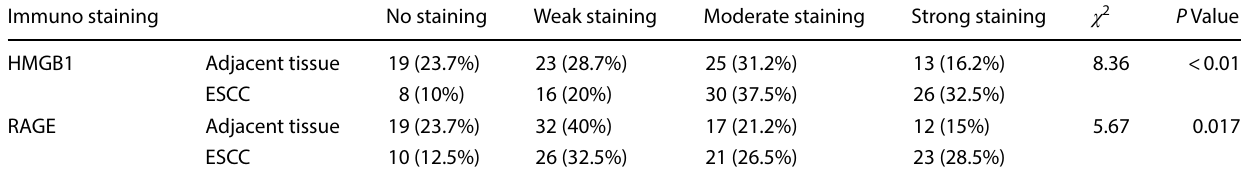
Table 2 Immunohistochemical analysis of HMGB1 and RAGE expression patterns in two groups including ESCC group and adjacent esopha- geal tissue group